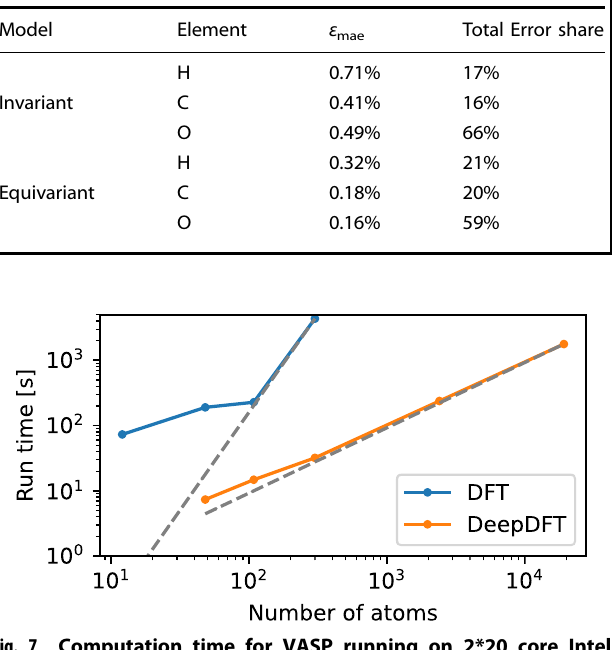
Fig. 6 Prediction error isosurfaces of ± 0.003 e Bohr − 3 with model based on invariant representation to the left and model based on equivariant representation to the right. The ethylene carbonate molecule contains hydrogen (white), carbon (brown) and oxygen (red). Table 2. Prediction errors of liquid ethylene carbonate data test set decomposed into Bader volumes for each atom type.